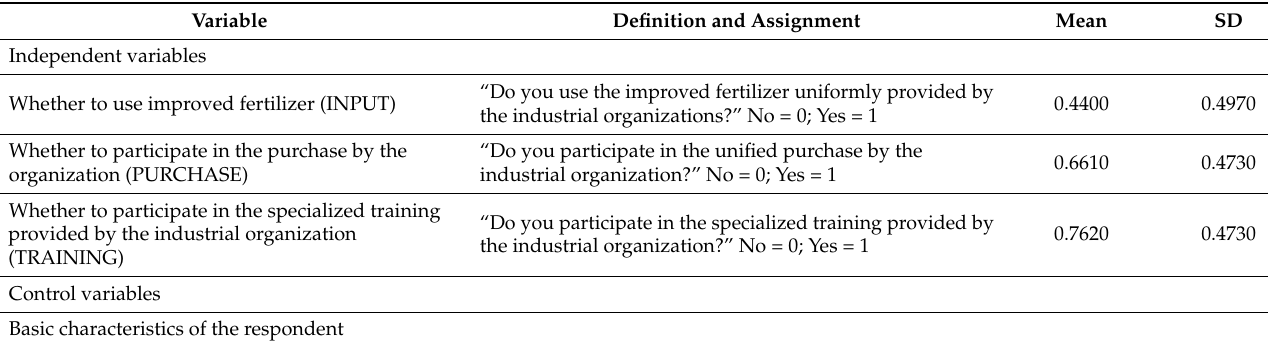
Table 1. Definition and descriptive statistics of